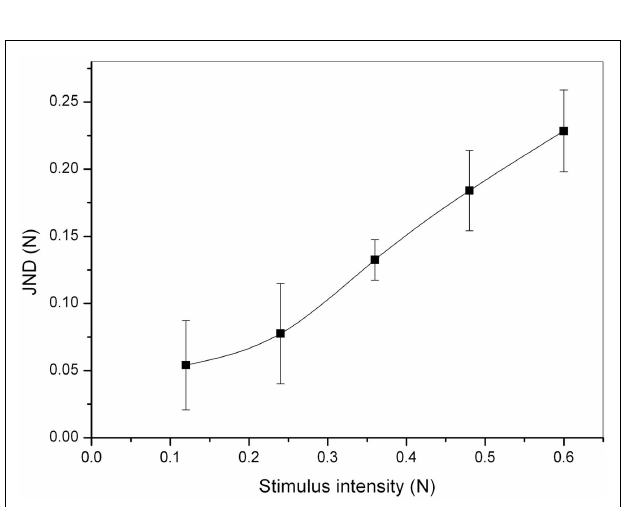
FIGURE 10 | Outcome of the psychophysical tests: JND as a function of the stimulus intensity (force) . Error bars represent a 95% confidence